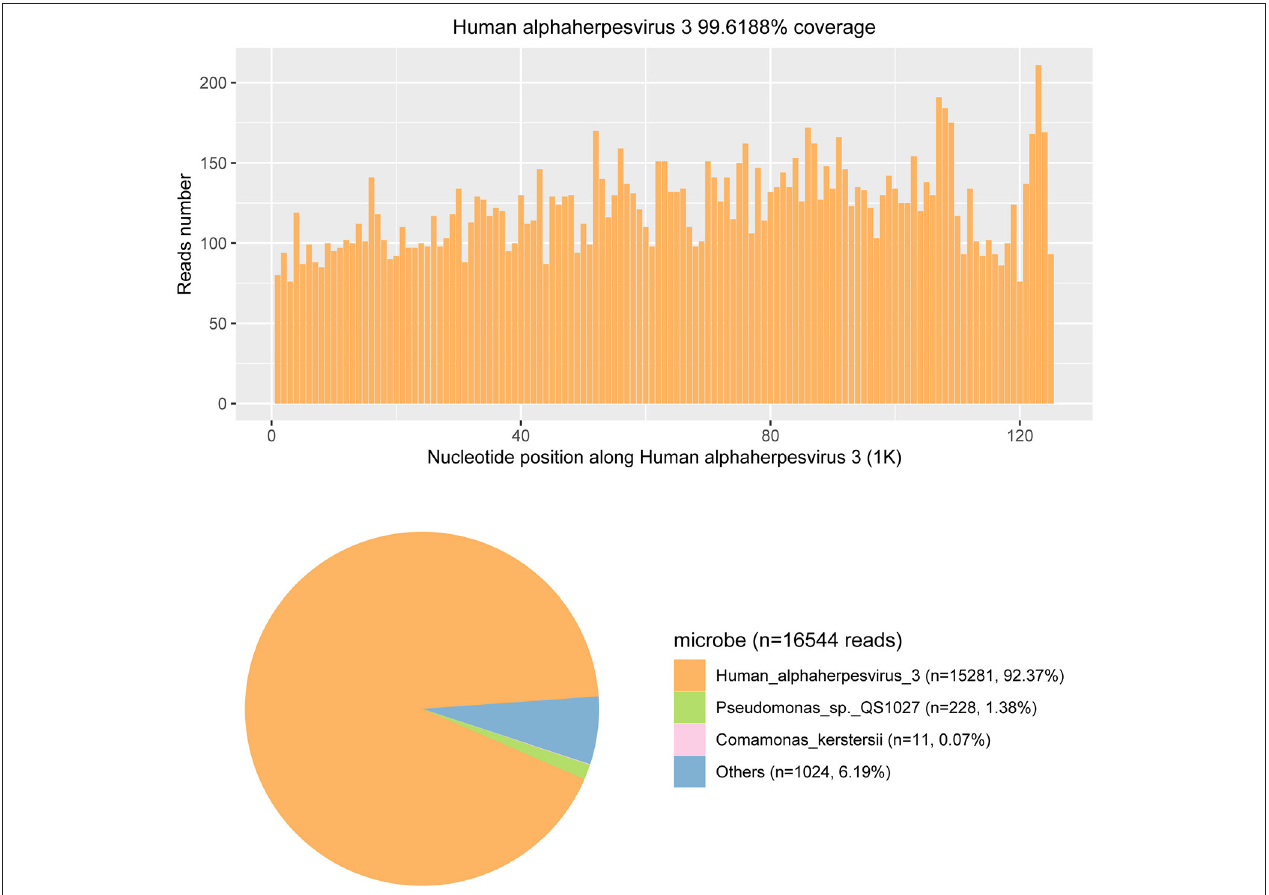
FIGURE 4 | The metagenomic next-generation sequencing (mNGS) results of pathogen identification. Approximately 92.37% of viral reads corresponded to Human alphaherpesvirus 3 (also named the Varicella-zoster virus) with coverage of 99.6188% in